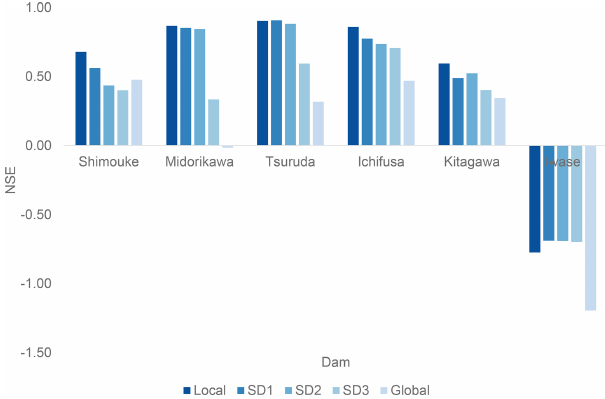
Figure E2. Sensitivity analysis for reservoir release. See Table E1 for the simulation